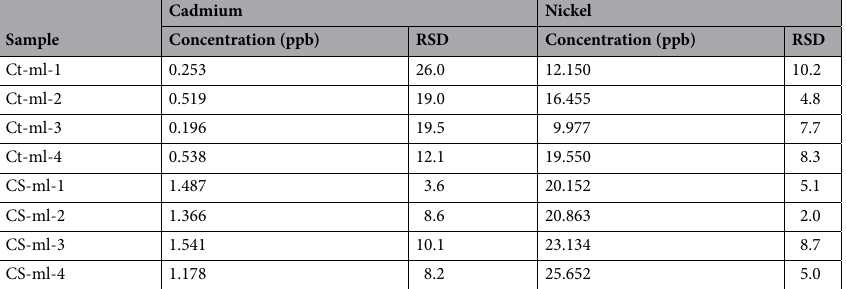
Table 1. Mass spectrometry-based metal ions analysis of lungs from mice exposed to cigarette smoke (CS) and age-matched, untreated control mice. The quantification shows differential concentrations of cadmium (Cd), and nickel (Ni) in the lungs of mice exposed to CS. The metal ion concentrations are normalized for sample mass and dilution. The metal ion concentrations are a mean value of five scans. RSD (relative standard deviation) is standard deviation divided by the mean value of the five scans (concentration in Table 1) and reported as a percentage. The detection limits were 0.2, and 2.0 ppb for Cd, and Ni respectively. Ct-ml control mouse lungs, CS-ml cigarette smoke-exposed mouse lungs, ppb parts per billion (also equilment to